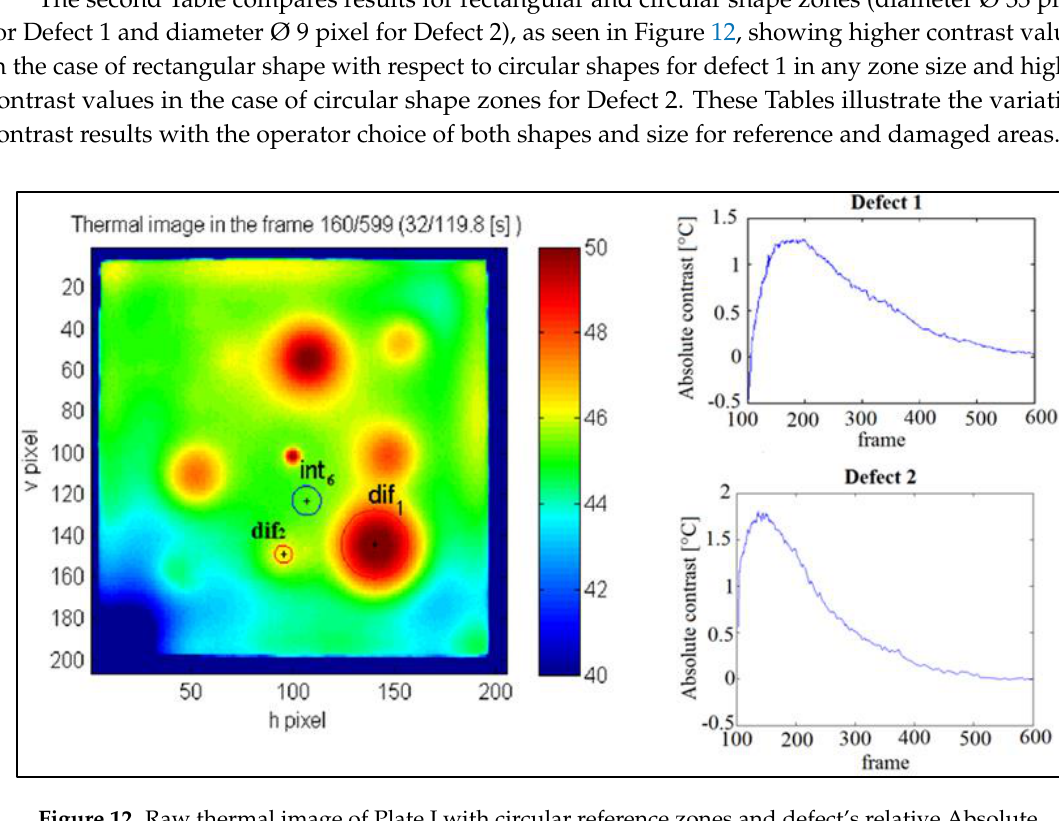
Figure 12. Raw thermal image of Plate I with circular reference zones and defect’s relative Absolute contrast examples.